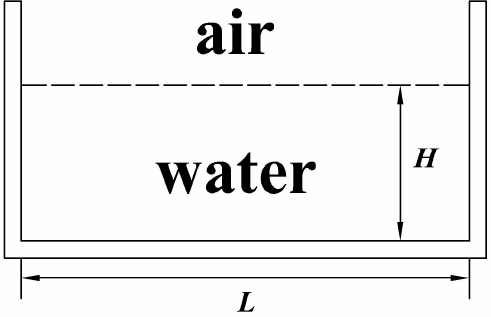
Figure 3. Rectangular vessel with water.